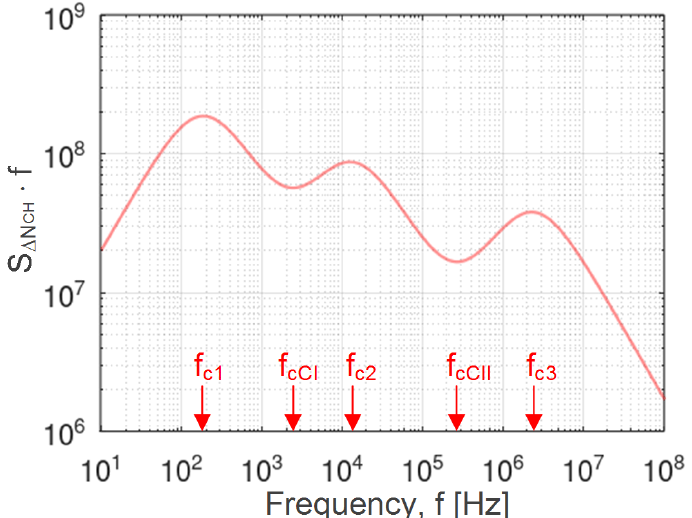
Figure 3. Noise spectrum (the power spectral density of fluctuations of the number of electrons included in the charge transfer between the adsorbed CO 2 molecules and the heterogeneous sensing material) multiplied by the frequency. There are three types of adsorption sites since, apart from edge and oxygen-free basal plane sites, functionalized sites occupied by O 2 molecules are considered. Five characteristic spectrum features (three maxima and two minima) are clearly distinguishable. The five characteristic frequencies of the spectrum are shown.